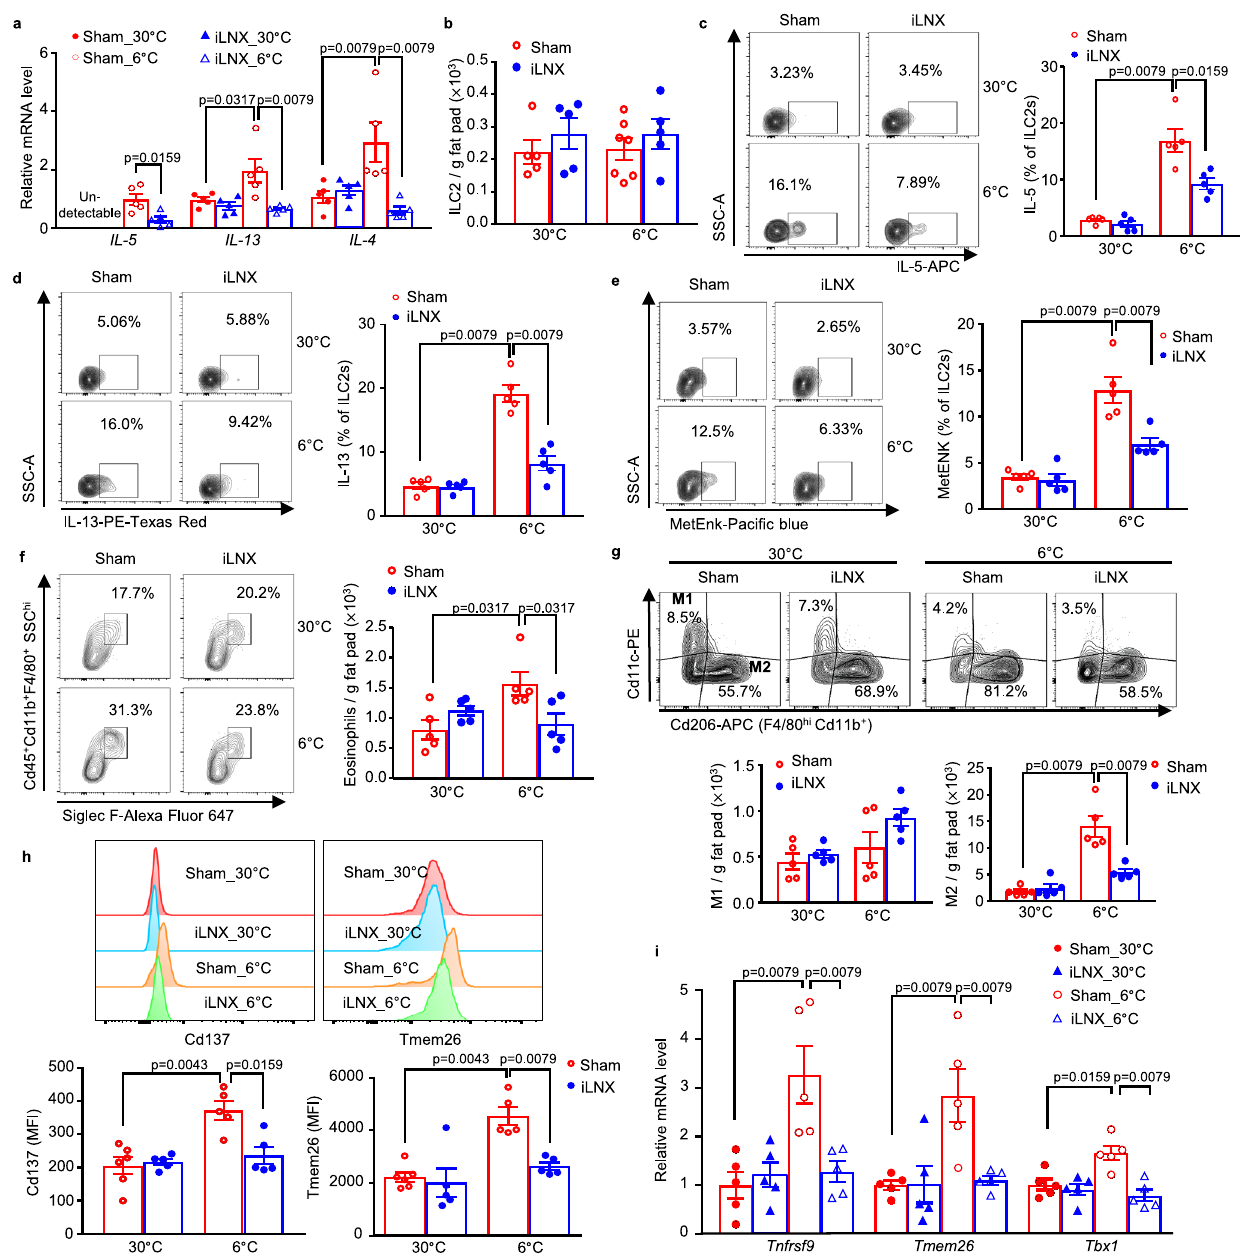
Fig. 2 | iLN regulates cold-induced activation of ILC2s, recruitment of eosino- phils, polarization of M2 macrophages and beiging of adipocytes in scWAT. SVF wasisolated from inguinalscWATof11-week-oldiLNX or sham-operated male C57BL/6N mice after housing at 30°C for 3 weeks and subsequently subjected to 30°C or 6°C for 2 days. a The mRNA expression of type 2 cytokines ( n =5). b The absolute number of ILC2s (Lin - Cd5 - Cd45 + Cd127 + IL33R + ) in entire scWAT. For Sham_30°C, iLNX_30°C and iLNX_6°C ( n =5) or Sham_6°C ( n =7). c – e Repre- sentativecontourplotsforILC2s(left)and quanti fi cationof thepercentage(right) of IL-5- ( c ) IL-13- ( d ) and MetENK- ( e ) positive cells in activated ILC2s from scWAT ( n =5). f Representative contour plots for eosinophils (CD45 + CD11b + F4/80 + SiglecF + SCC hi ) (left) and quanti fi cation of the absolute number of eosinophils in entire